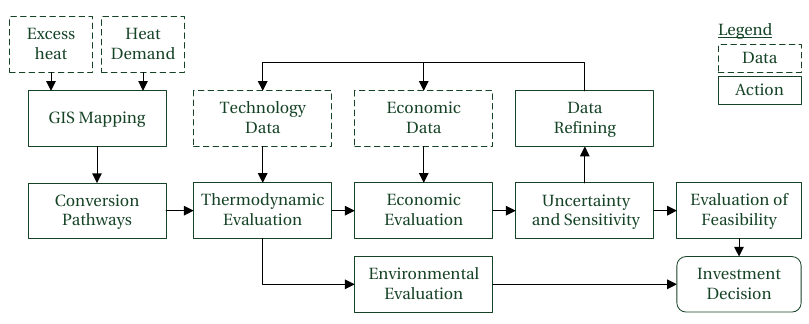
Figure 1. Overview of the method for evaluating the feasibility of different cases for the EH utilization